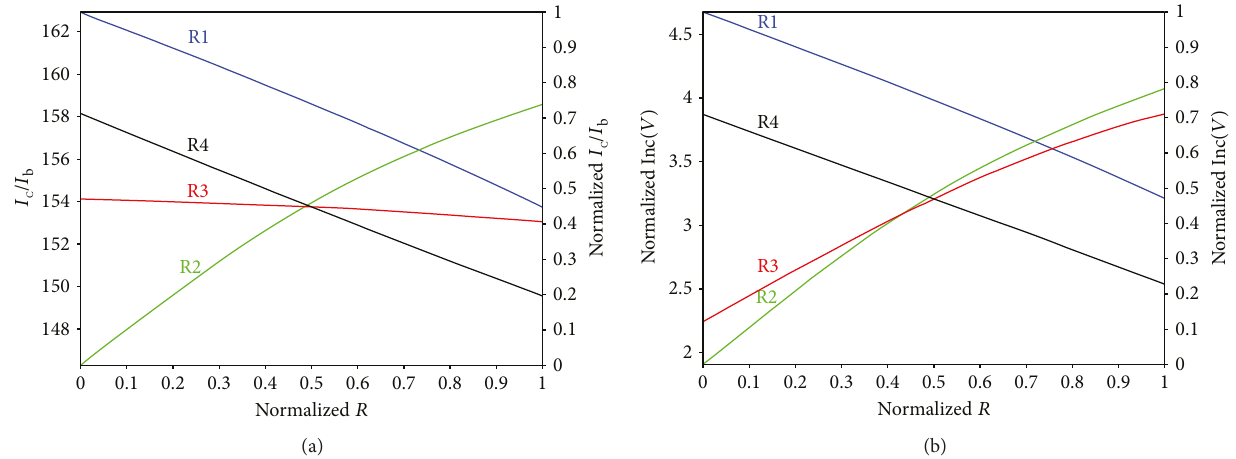
/ I Δ V values obtained with the C B and the